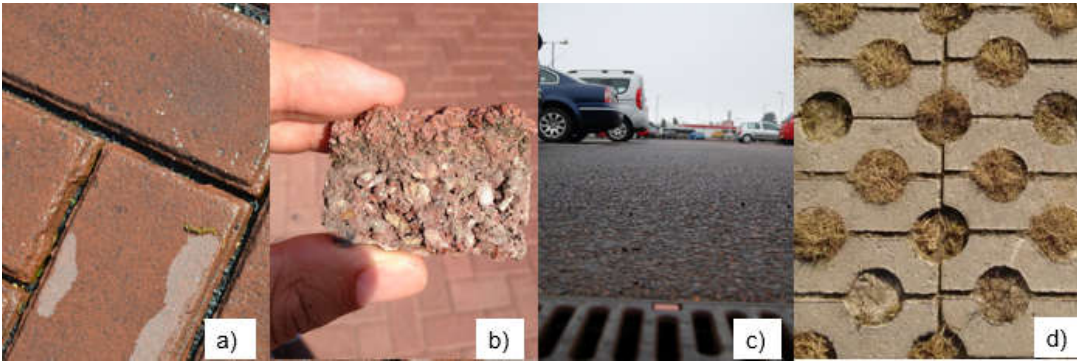
Figure 1. ( a ) Impermeable concrete interlocking pavers; ( b ) porous concrete; ( c ) porous asphalt; ( d ) grass-filled grid pavers.